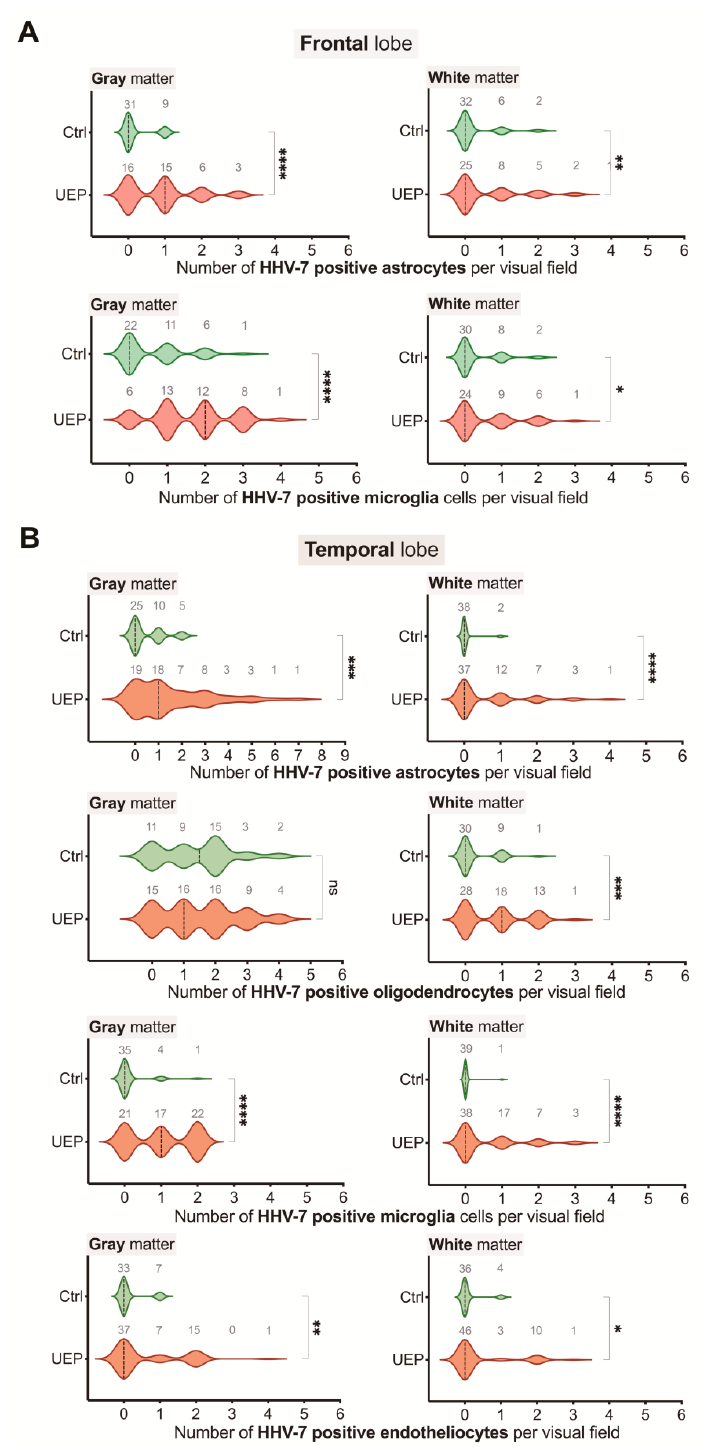
Figure 5. Violin plots representing the data of herpesvirus-7 (HHV-7) analysis in the PCR+ samples: ( A ) distribution of HHV-7 positive cells per visual fields in the gray and white matter of the control (Ctrl) and unspecified encephalopathy (UEP) group, frontal lobe; ( B ) distribution of HHV-7 positive cells per visual fields in the gray and white matter of the control (Ctrl) and UEP group, temporal lobe; violin plots with dashed lines representing the approximate ratio of respective visual fields with HHV positive cells to fields with HHV negative cells (“0”— ratio less than 1.0, “1”— more than 1.0); numbers in gray show visual fields; asterisks represent a significance level (* p < 0.05, ** p < 0.01, *** p < 0.001, **** p < 0.0001; Mann-Whitney